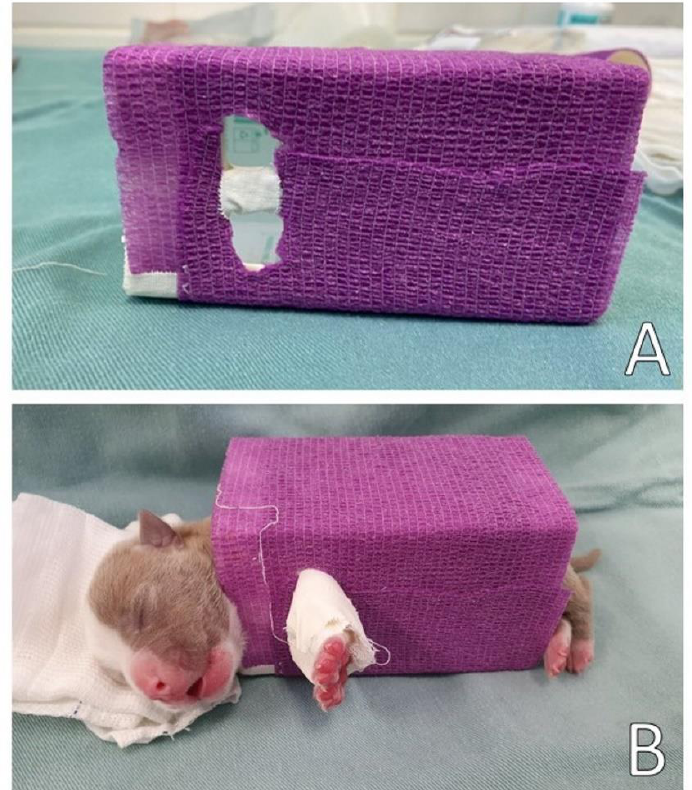
Figure 12. Box management. ( A ) Resistant paper box with space to insert and immobilize the previous members. ( B ) Puppy immobilized in the lateral decubitus position.